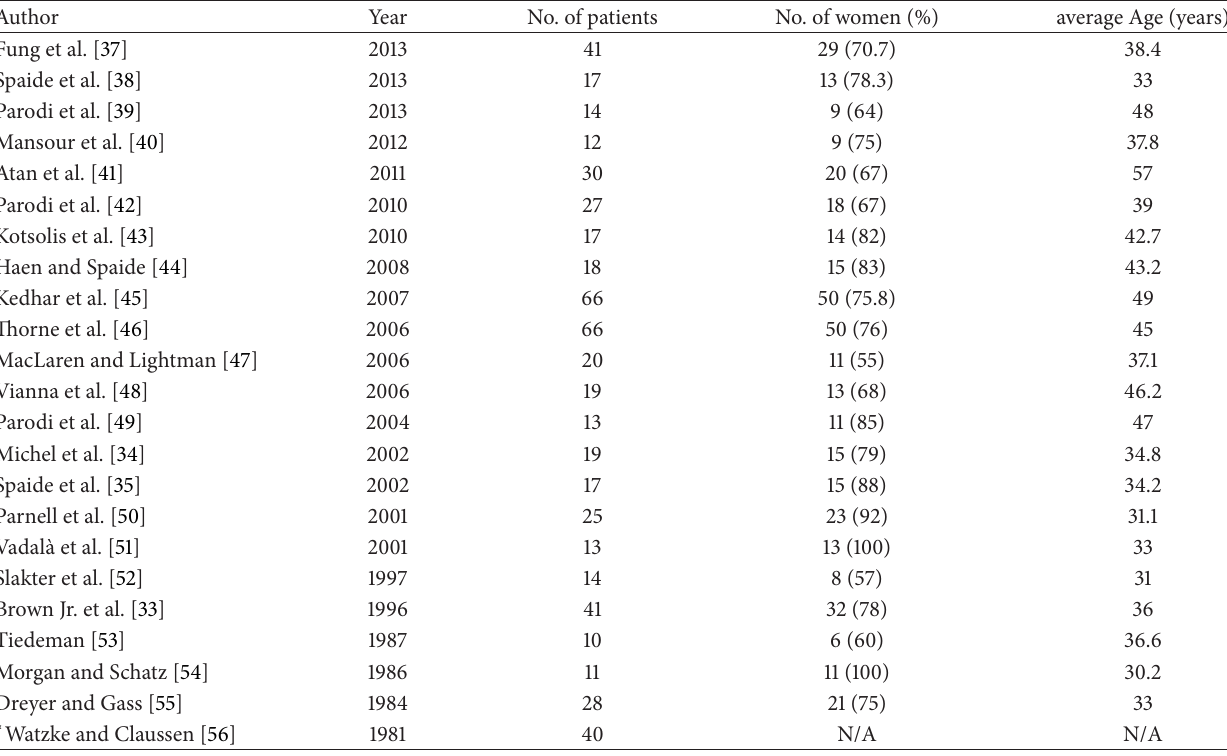
Table 4: Reports for multifocal choroiditis and panuveitis.